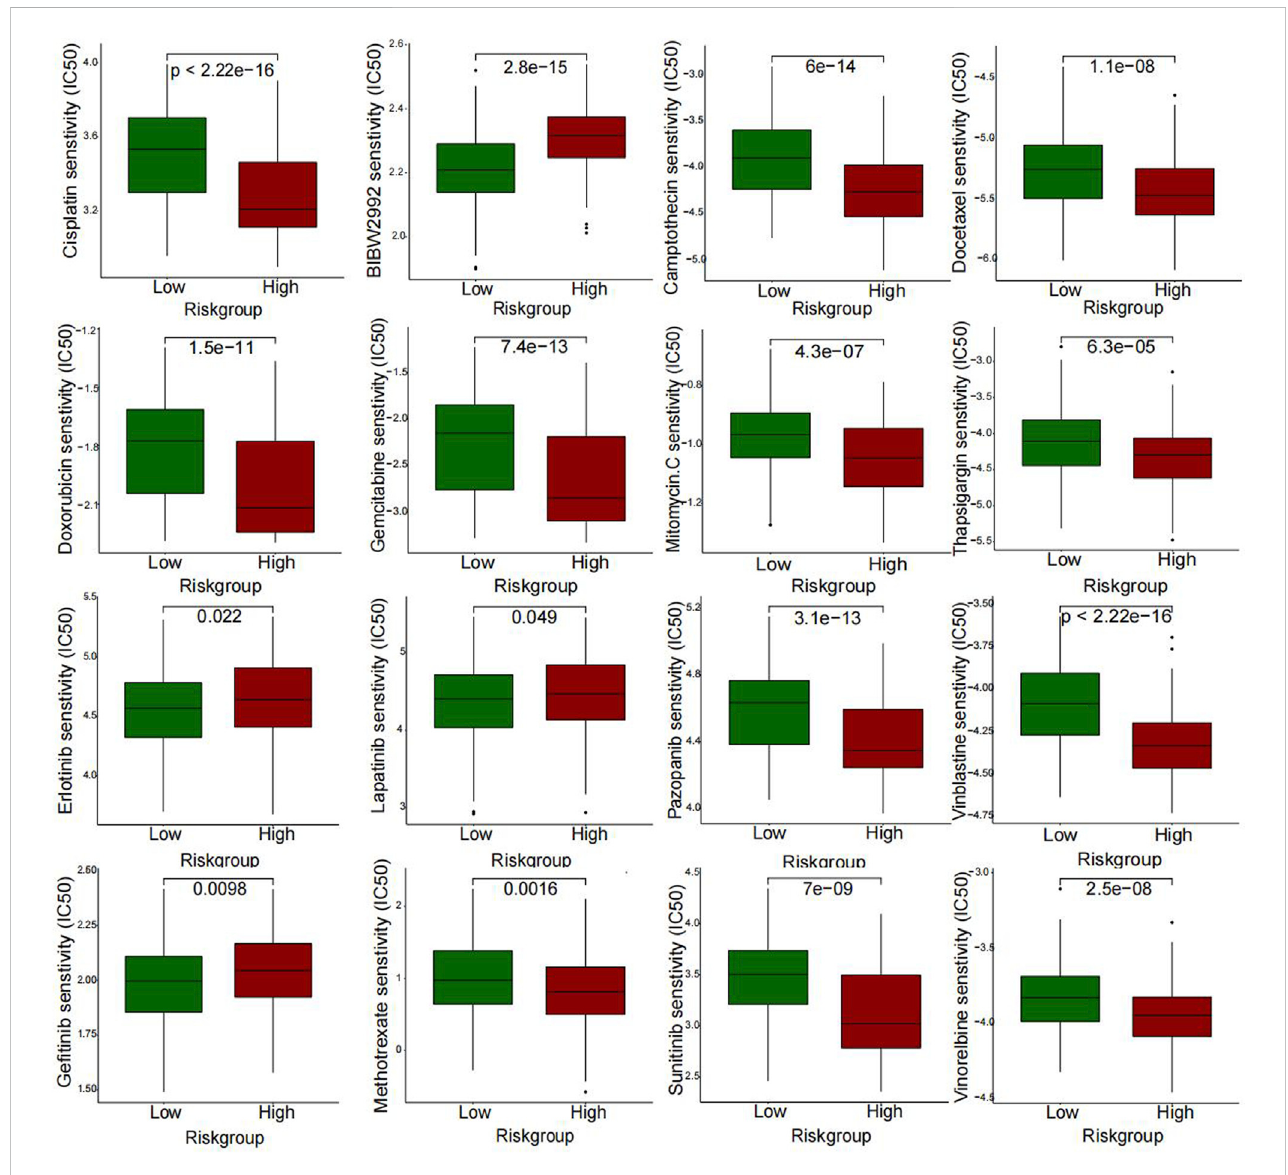
FIGURE 9 Differences in drug sensitivity between the two